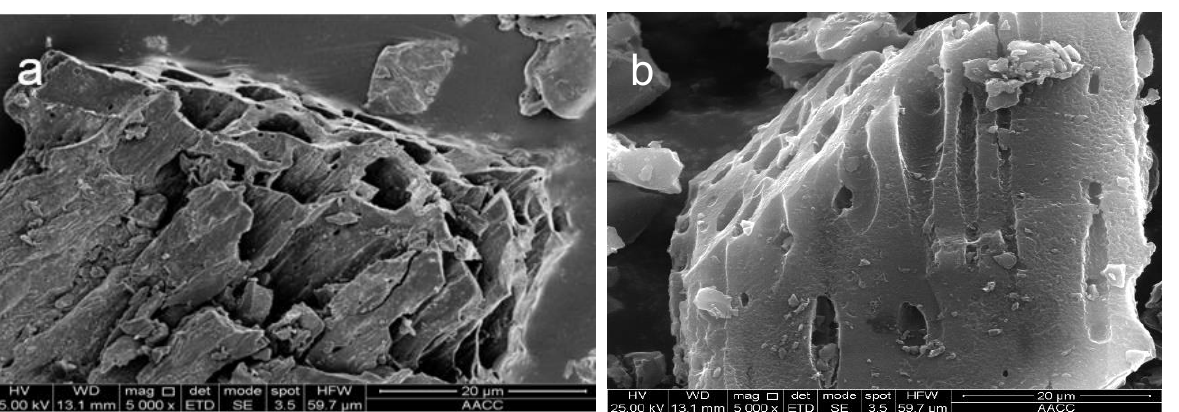
Figure 1. ( a ) Nitrogen adsorption/desorption isotherms of the BPC and FBPC samples; ( b ) nitrogen adsorption/desorption isotherms; and ( c ) DFT pore size distribution of the FBPC samples.